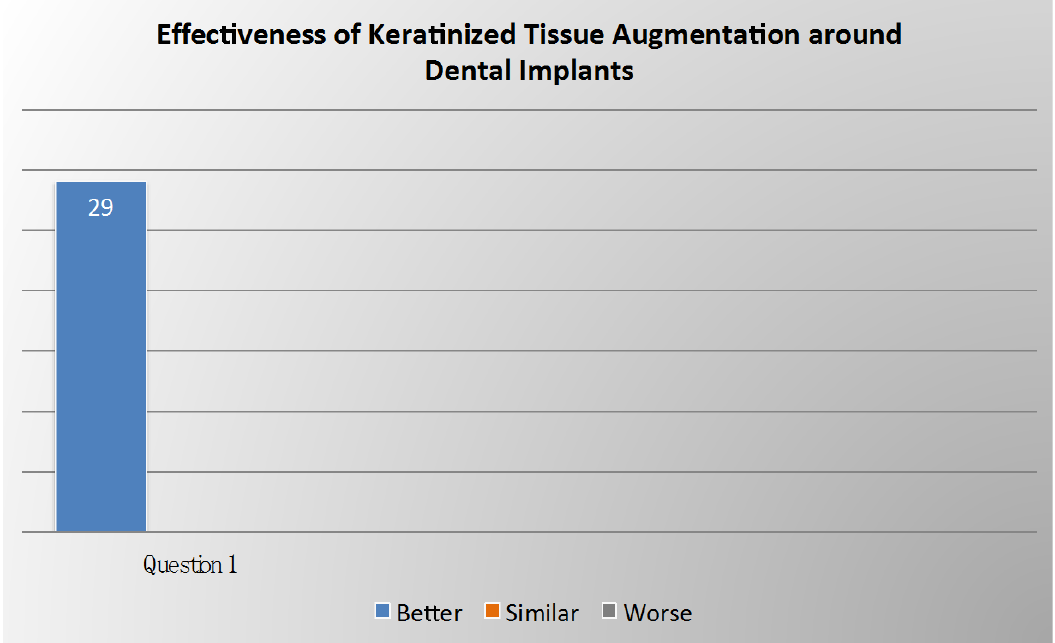
Figure 4. Voting results from the panel of experts regarding the effectiveness of keratinized tissue augmentation around dental implants. augmentation around dental